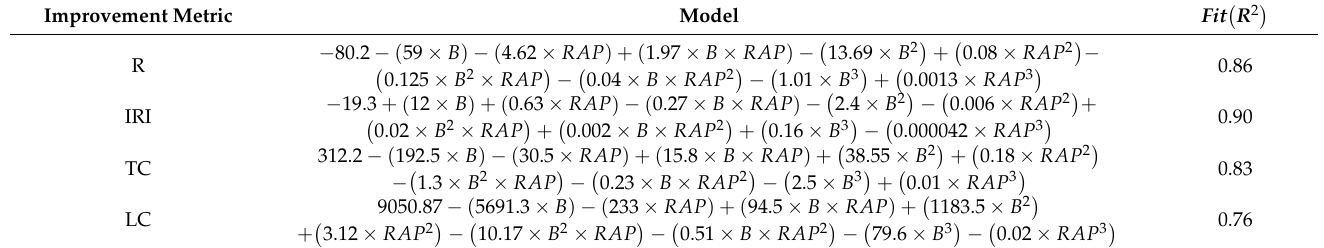
Table 3. Regression models for improvements under wet